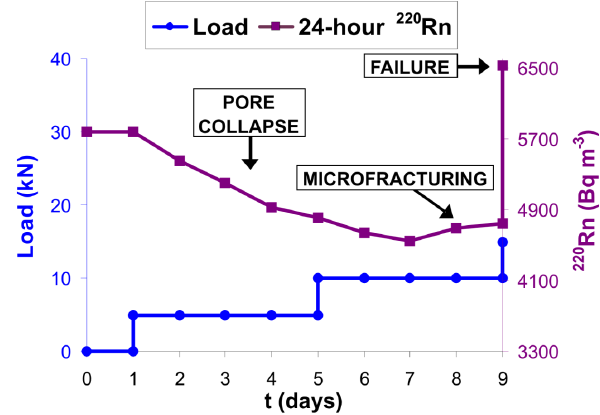
Figure 4. Deformation-dependent radon concentration (DDRC) R1 experiment, at constant temperatures of 90 ◦ C. The uniaxial load and 24h average 220 Rn activity concentration are plotted versus the experimental time. Six different load steps of 2, 4, 6, 8, 10, and 12kN were used and the load was maintained constant for 1 day for each step. 220 Rn activity concentration invariably decreases with in- creasing load due to pore collapse. At 12kN, the load was increased up to sample failure and the thoron signal substantially increased due to the formation of macroscopic exhaling surfaces.